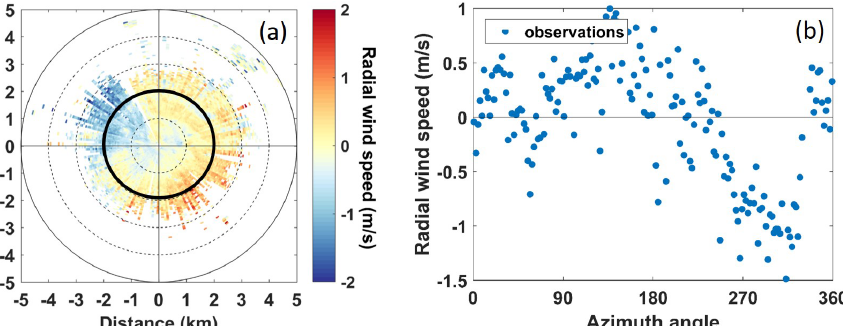
Figure 4. A case when the VAD method cannot be applied: (a) radial wind field on 25 September 2014 at 23:42UTC and (b) radial wind speed (blue dots) as a function of the azimuth angle at a fixed 2km distance from the lidar (black circle on a